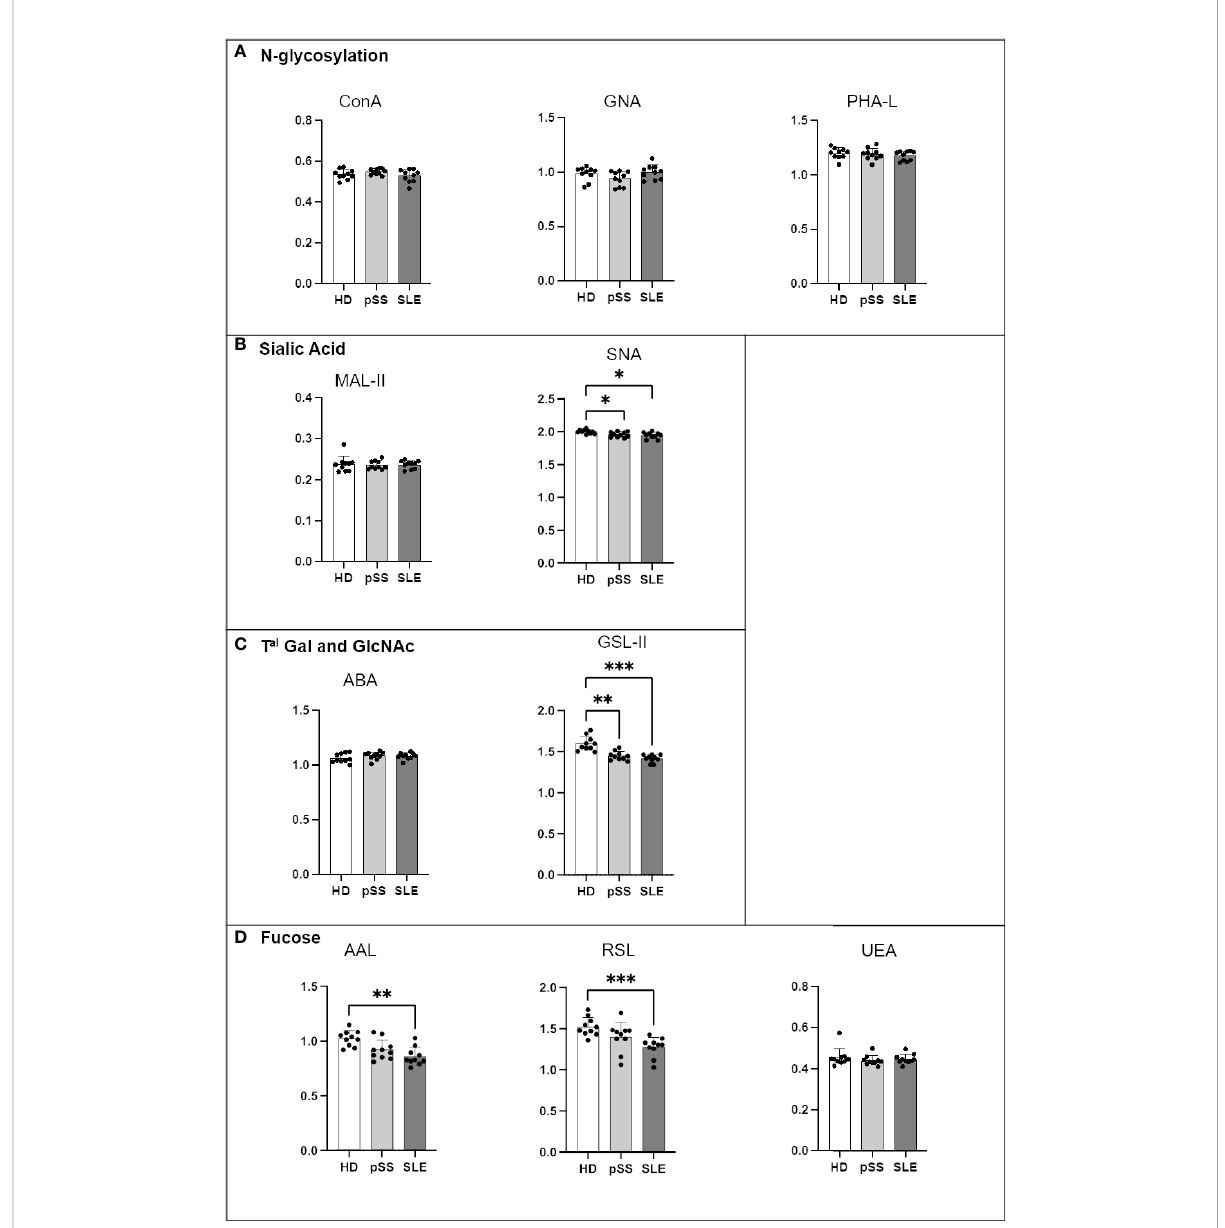
FIGURE 9 Comparison of IgG N-glycosylation from systemic lupus erythematosus (SLE), primary Sjögren ’ s syndrome (pSS) and healthy donors (HD). Mouse anti-Human IgG (4A10 clone) was coated at 0.5 µg/mL in MaxiSorp 96-well plates overnight at 4°C. A PBS solution containing 2% of BSA or Carbohydrate-Free Blocking Solution were used for saturation depending on the lectins. This information is described in Table 4. After saturation, an oxidation was performed, to cleave terminal glycans present on anti-Ig and saturating buffer, with a solution of sodium periodate at the fi nal concentration of 0,05 M in 0,0 5M pH=4 citrate buffer. Serum from healthy donors HD, pSS and SLE diluted to 1/100e were added for 1h at 37°C. After 5 wash steps with PBS 0,0 5% Tween20, the biotinylated lectins described in Table 2 were added for 1h. Plate was washed 5 times and streptavidin-HRP was added for 30 min at RT. After 5 wash steps, a colored reaction using tetramethylbenzidine was performed and stopped with sulfuric acid. The optical density (OD) at 450 nm was determined. Results are presented as followed: N-glycosylation in (A) , Sialylation in (B) , Terminal (Tal) Gal and GlcNAc on N and O-glycosylation in (C) , and Fucosylation in (D) . One-way anova test followed by Dunn ’ s multiple comparison test were performed. ns: not signi fi cant p > 0,05, stars are indicated when p< 0,05 (*); < 0,01 (**); < 0,001